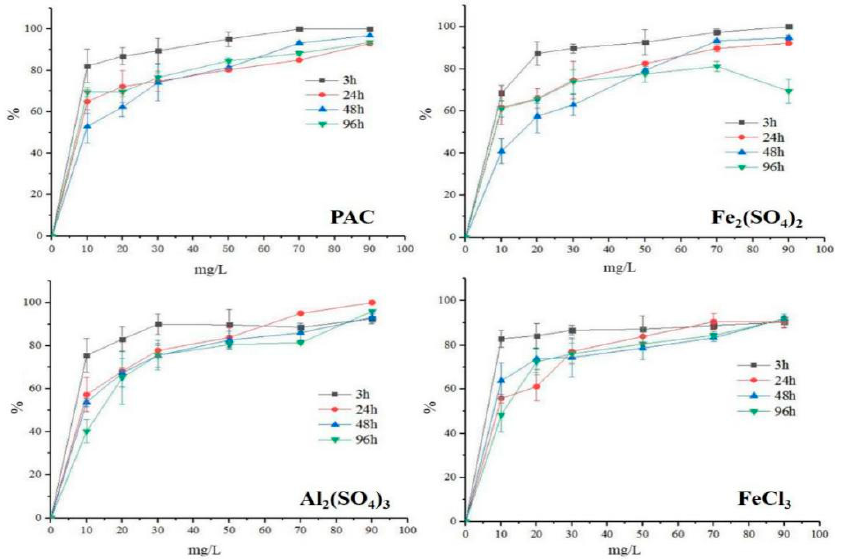
Figure 1. Removal effect of four different coagulants on G. catenatum.